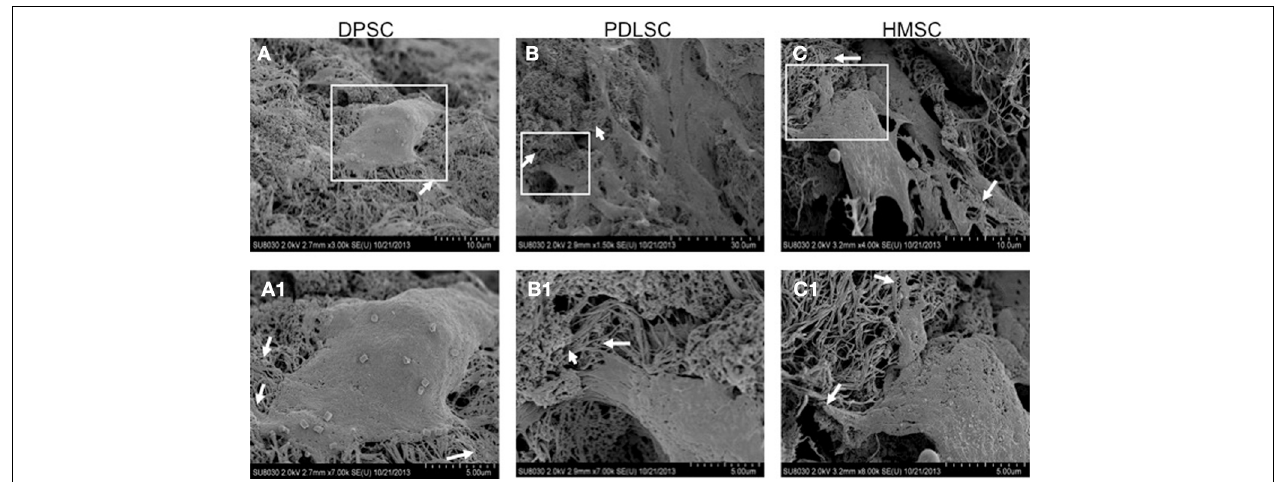
FIGURE 3 | Scanning electron microscopy. The SE micrographs are representative images of DPSCs (A) , PDLSCs (B) , and HMSCs (C) in the pulp ECM scaffolds. The boxed areas in (A–C) are represented in